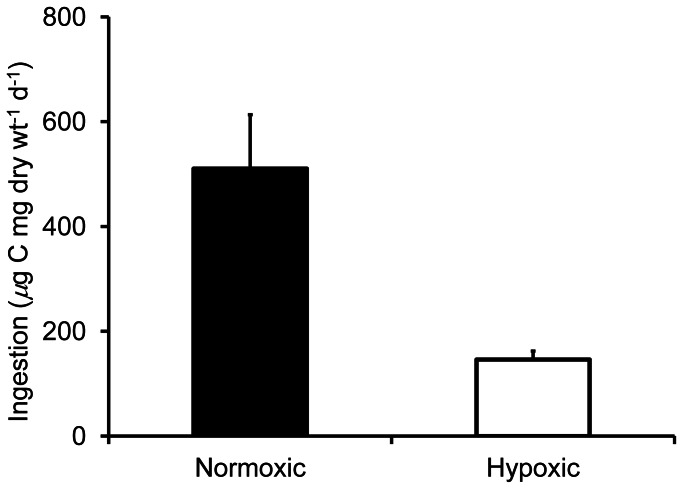
Feeding by Acartia tonsa in normal and low oxygen water.Ingestion rates of adult female Acartia tonsa under incubation conditions of hypoxia (mean oxygen 5.0 kPa = 2.1 mg L−1 = 1.6 mL L−1) and normoxia (mean oxygen 19.9 kPa = 8.3 mg L−1 = 6.2 mL L−1). Data are graphed as means of three separate laboratory feeding experiments where animals were fed Rhodomonas sp. and incubated for 1–2 d. Error bars are+SD.